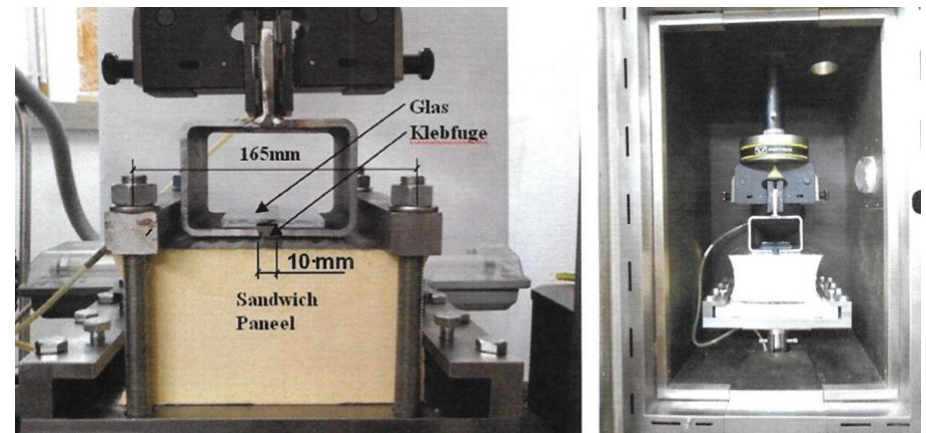
Fig. 5 Test setup for the transfer of tensile forces through the silicone joint into the PUR core for normal (left photo) and reduced/elevated temperature conditions (right photo).